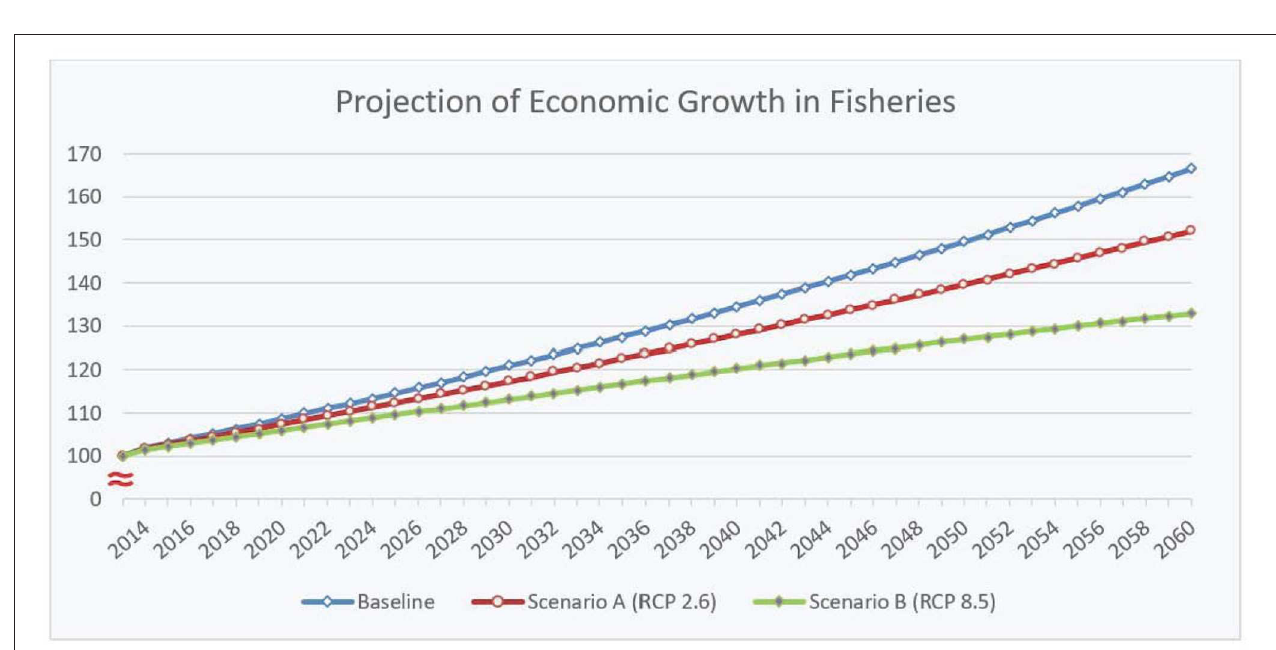
FIGURE 5 | Projection of decrease in contribution of capture-aquaculture combined fisheries to GDP by scenario.